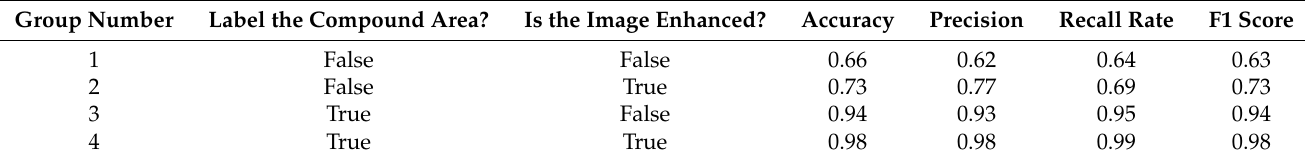
Table 3. Detection performance of different